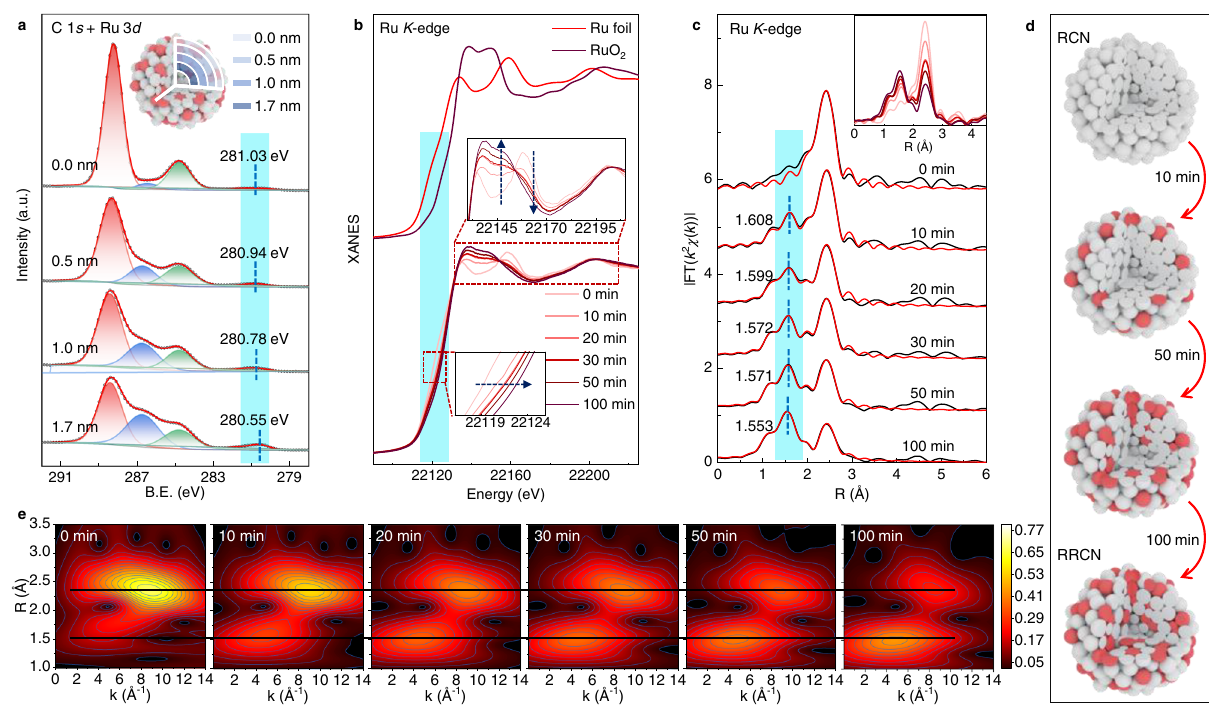
Fig. 3 | In situ oxygen impregnation process. a High-resolution XPS spectra at different sputtering depths for Ru 3 d of the RRCN sample. b In-situ XANES spectra recorded at the Ru K -edge of RRCN at different oxidation time during the heat process,andtheXANESdataofthereferencedstandardsofRufoilandRuO 2 .Inset, Magni fi ed absorption edge and white-line peak of XANES region. c Least-squares